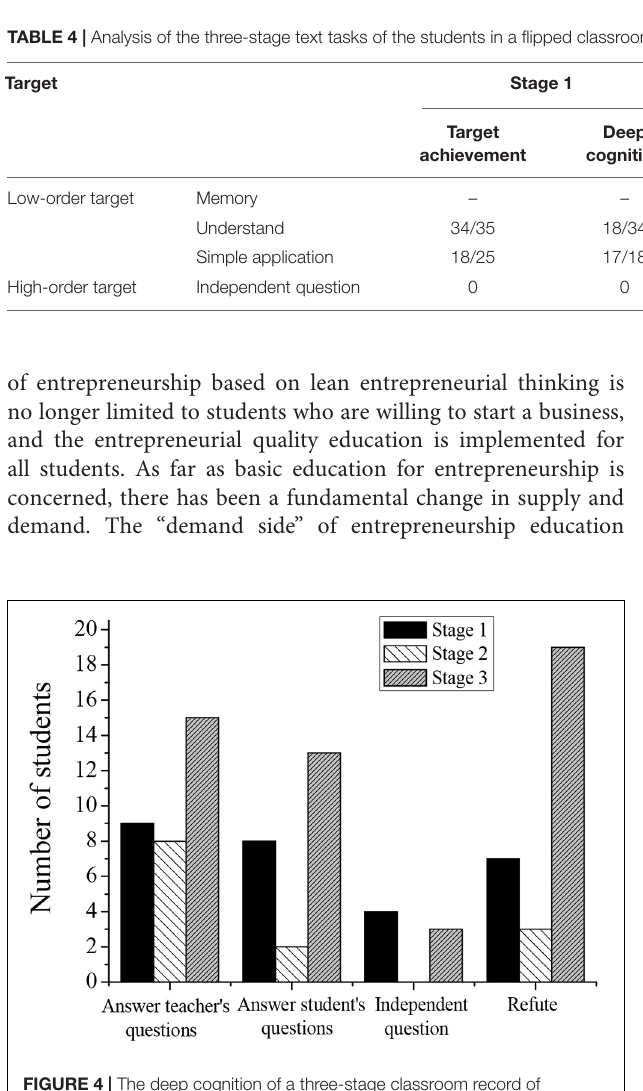
FIGURE 4 | The deep cognition of a three-stage classroom record of students.